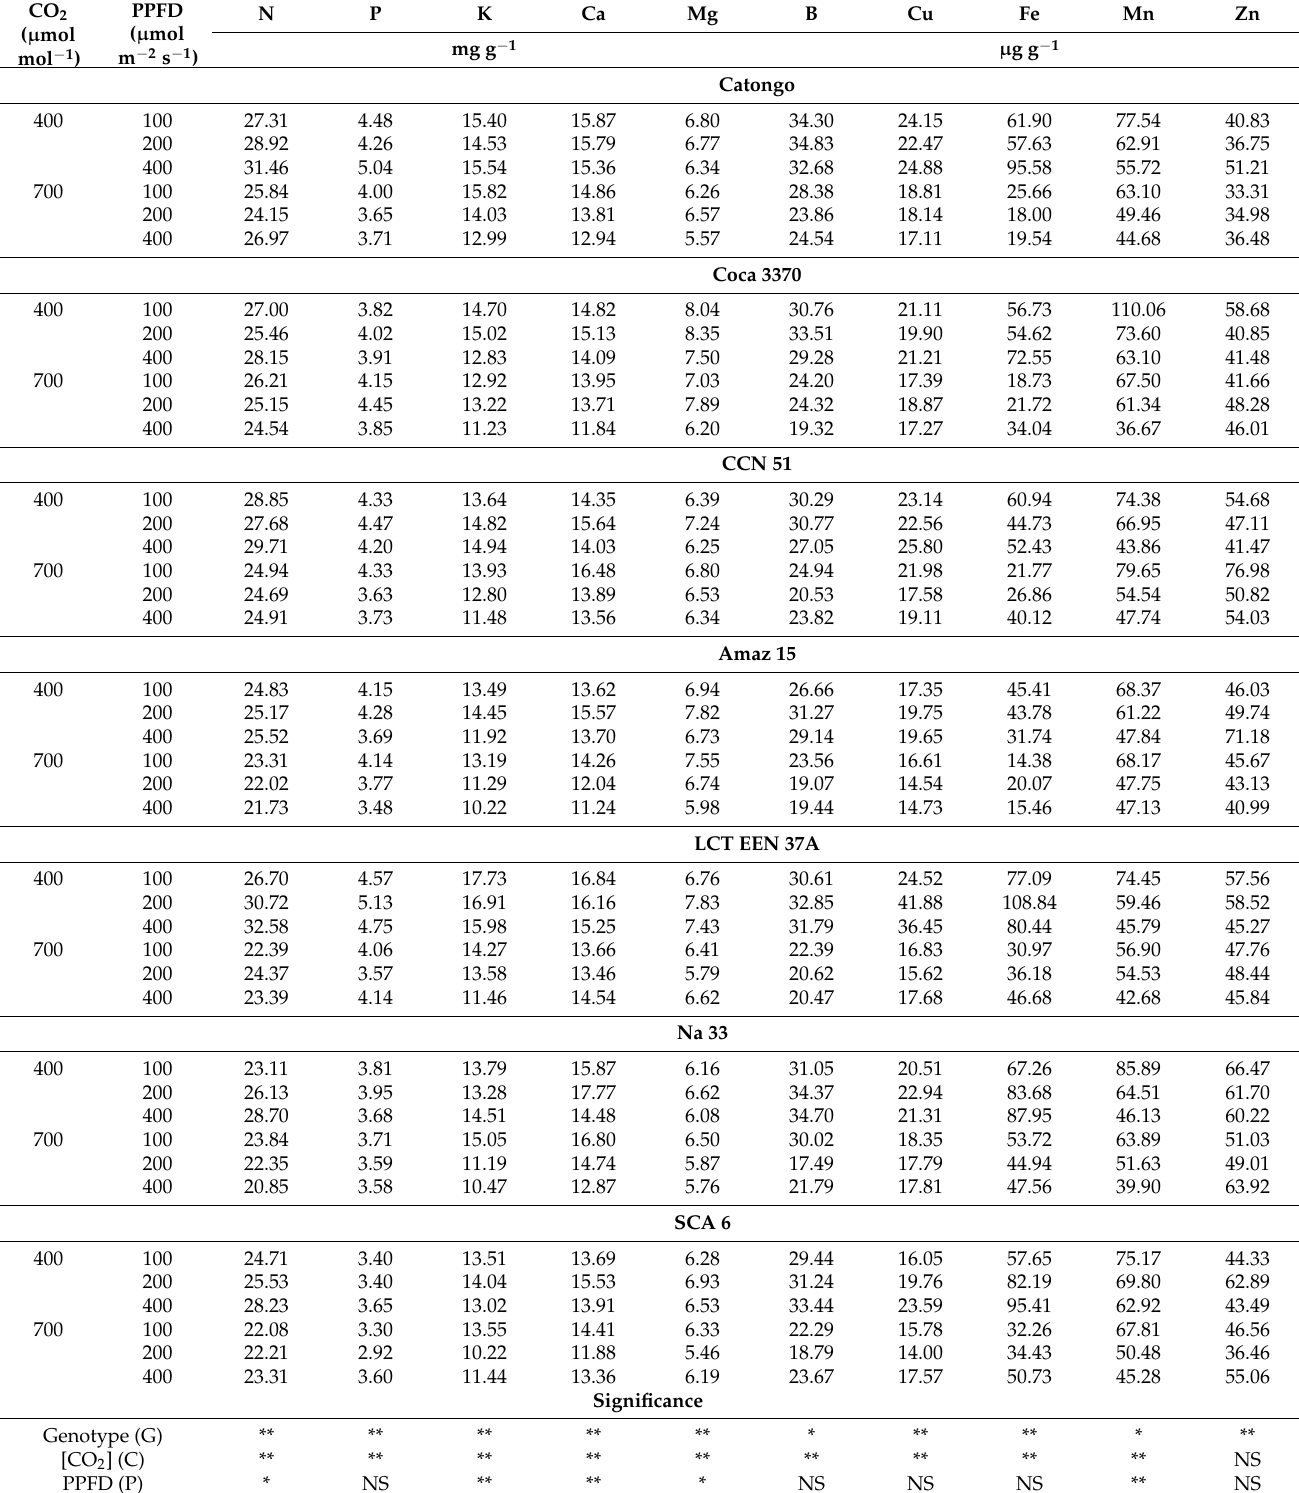
Table 3. The effect of [CO 2 ] and photosynthetic photon flux density (PPFD) on macro–micro nutrient concentrations of seven cacao